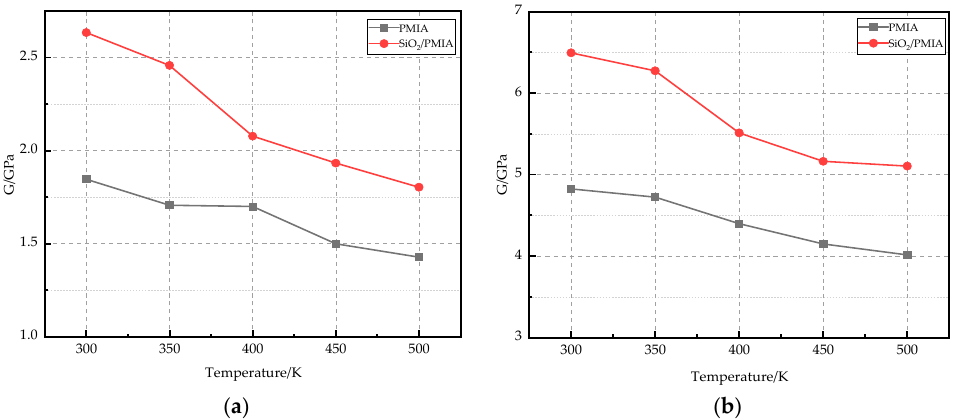
Figure 5. Mechanical properties at different temperatures. ( a ) Young’s modulus, ( b ) Shear modulus.